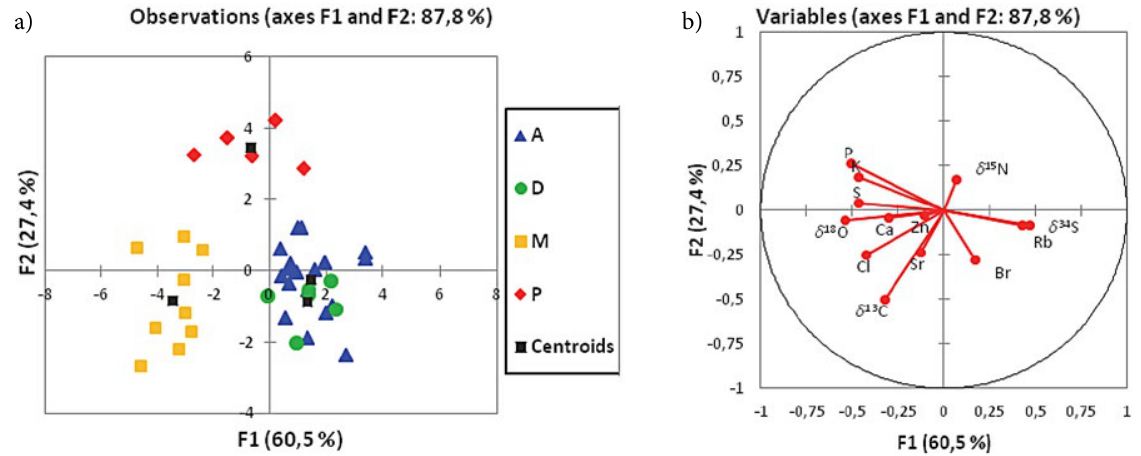
Fig. 3. (a) Discriminant score plots of 38 Slovenian garlic samples from the Alpine (A; n = 18), Dinaric (D; n = 6), Mediterranean (M; n = 9), Pan- nonian (P; n = 5) regions. ( b) Plot of correlations between initial variables and discriminant factors (F1, F2)